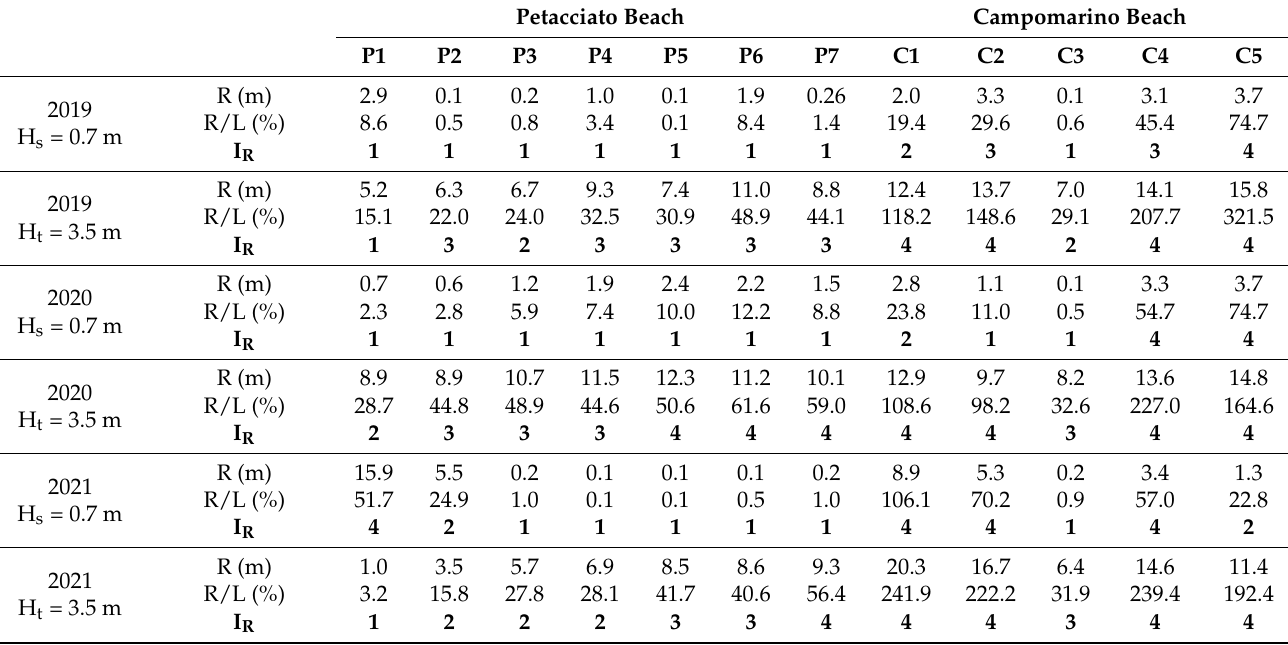
Table 9. Evaluation of short-term erosion indexes I R for profiles P1–P7 and C1–C5, based on R values calculated for normal wave (H s = 0.7 m) and average extreme wave conditions (H t = 3.5 m),